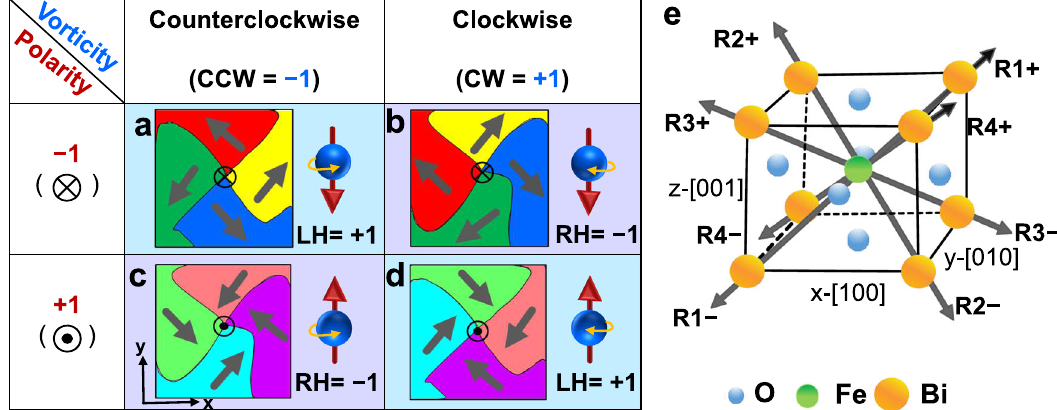
Fig. 1 Schematics of the four types of ferroelectric vortices with LH ( + 1) and RH ( − 1) chirality. LH vortex based on either a − 1 vorticity and − 1 polarity or d + 1 vorticity and + 1 polarity; RH vortex based on either b + 1 vorticity and − 1 polarity or c − 1 vorticity and + 1 polarity. The black arrows denote the in-plane polarization direction, and the cross and dot denote the downward or upward out-of-plane polarization direction, respectively. e The eight polarization variants along with the <111> BFO crystal